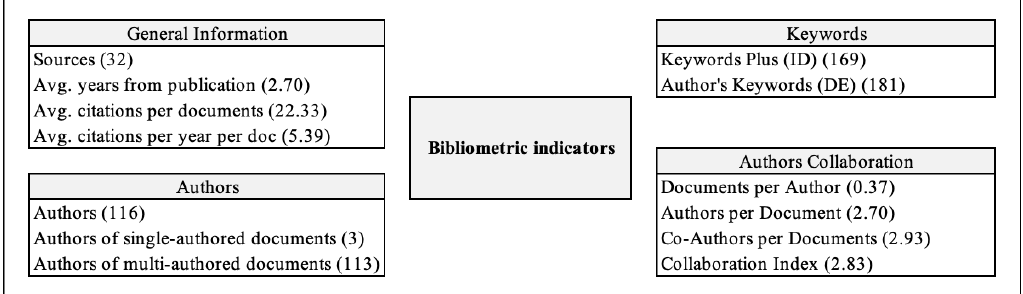
Figure 5. Classification of research approaches.